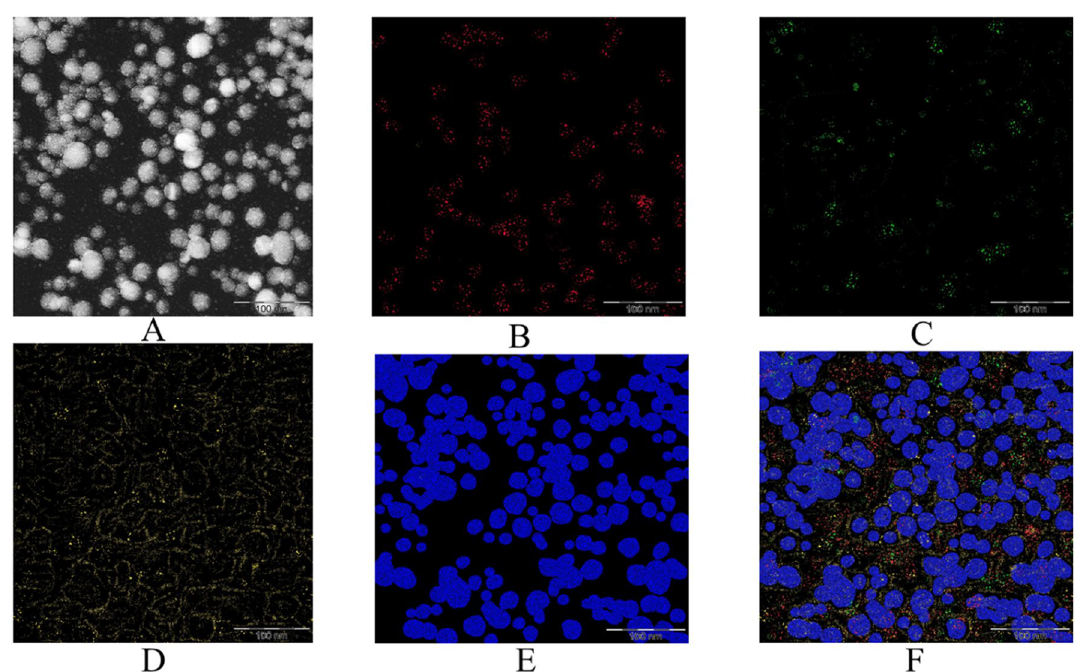
Figure 7. HAADF-TEM image and EDS maps of negative Se NPs sol at magnification × 640000: ( A ) HAADF- TEM image, ( B ) EDS maps of C, ( C ) EDS maps of N, ( D ) EDS maps of O, ( E ) EDS maps of Se, ( F ) EDS maps of all